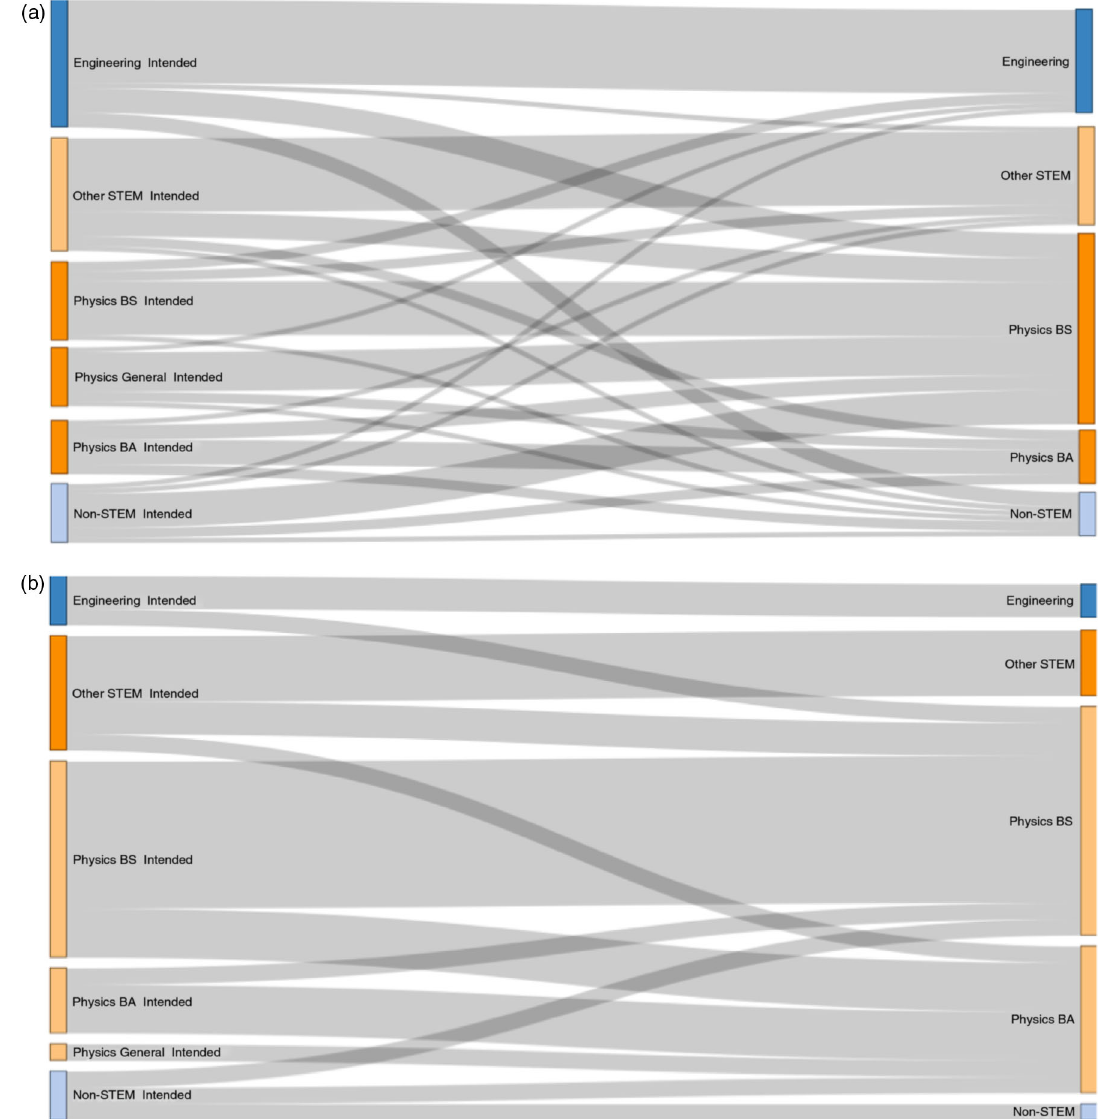
FIG. 1. (a) Sankey diagram depicting major intentions and pathways of men that attempted an upper level physics course and graduated on the right. 50% of men that graduated received a physics degree. (b) Sankey diagram depicting major intentions and pathways of women that attempted an upper level physics course and graduated on the right. 76% of women that graduated received a physics